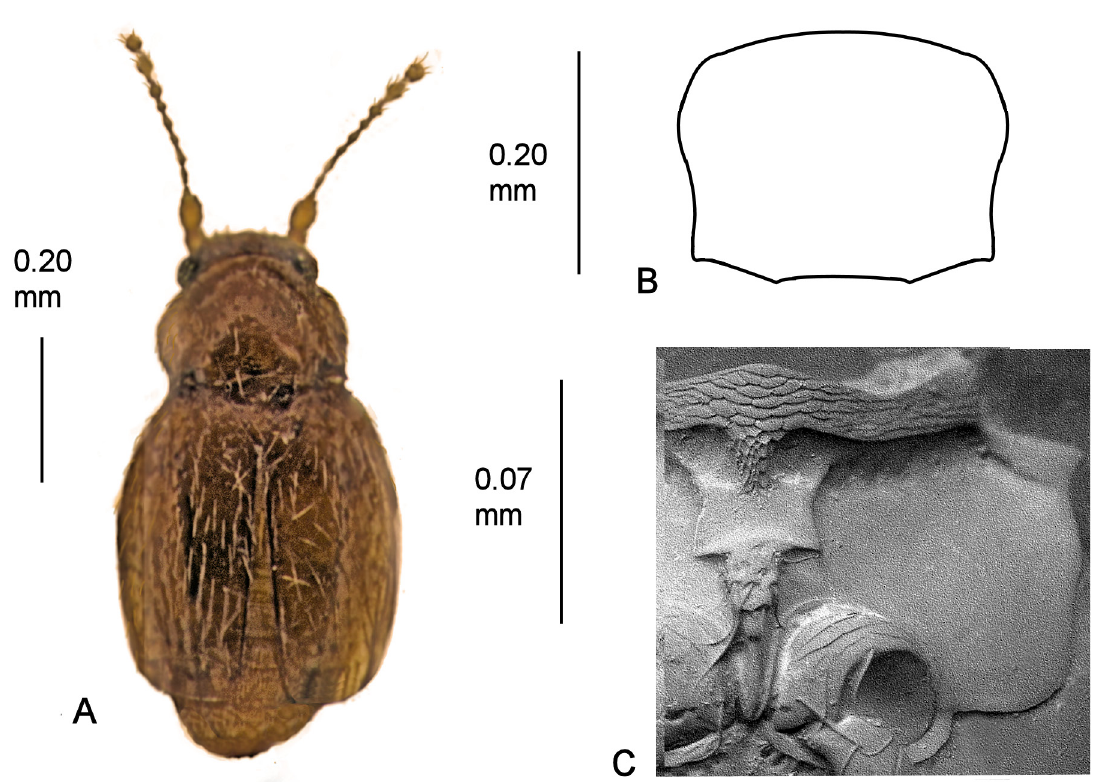
Fig. 72 . Cissidium globosum Darby, 2015. A . Habitus. B . Pronotum. C . Mesoventrite showing median process of collar, lateral margin, mid-keel and keel,